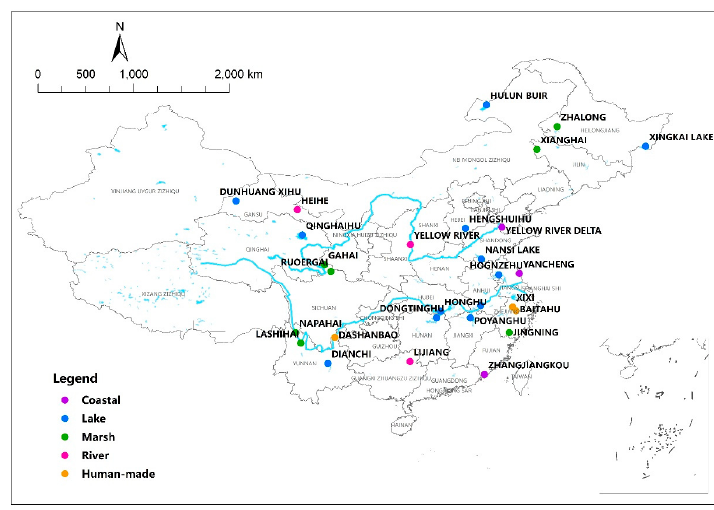
Figure 1. Locations of the 28 wetlands in this study in China.